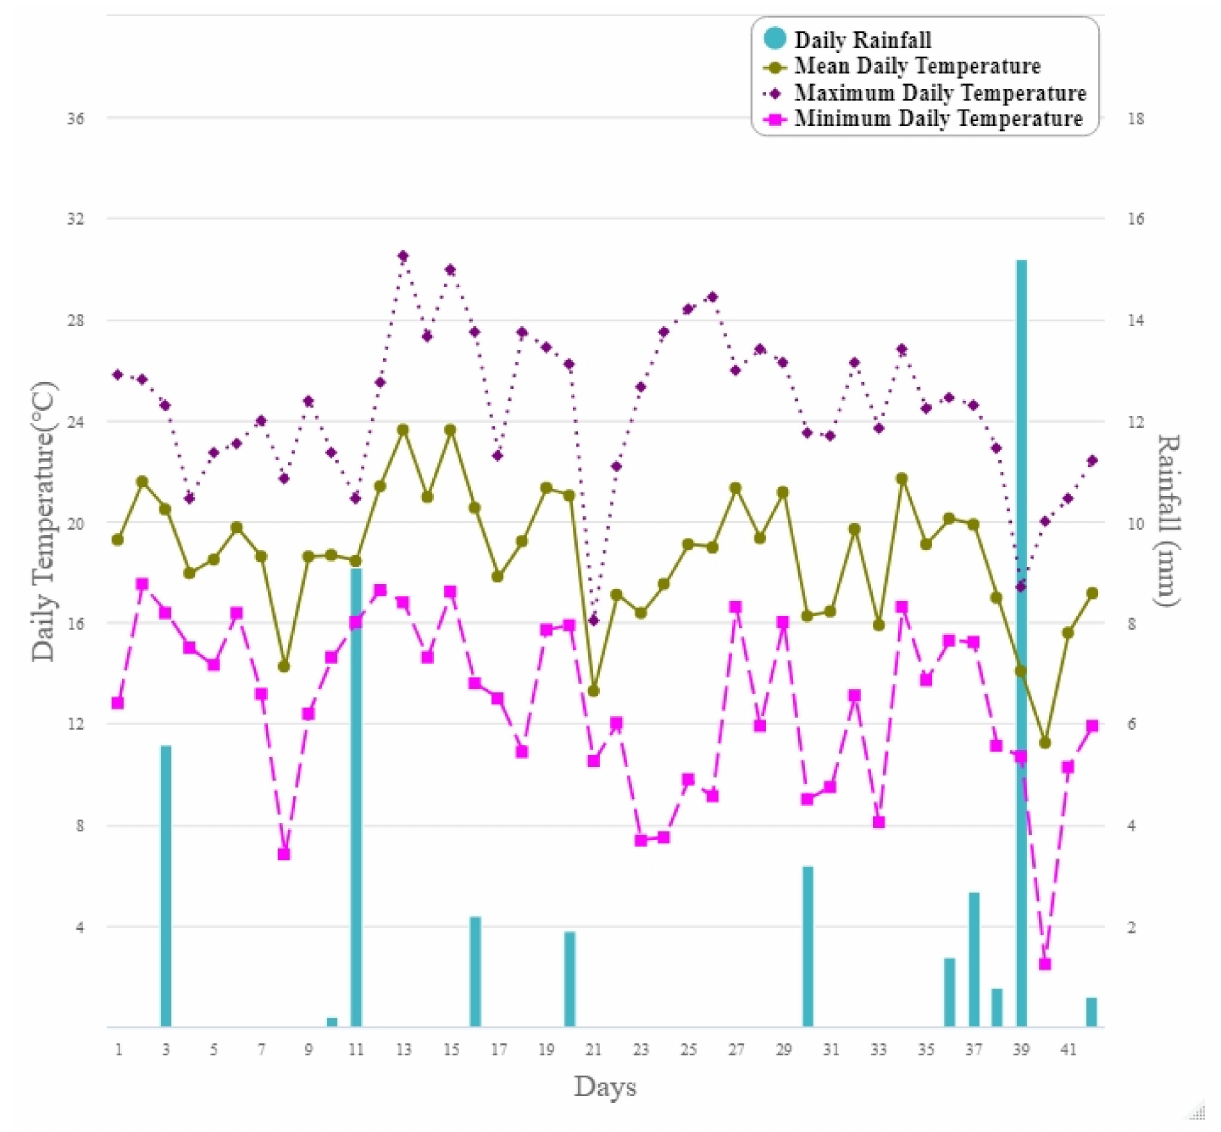
Figure 7. The mean, maximum and minimum temperature ( ◦ C) and rainfall (mm) over 42 days (18 January–1 March 2019) from Palmerston North Airport (40 ◦ 19 (cid:48) 15.6 (cid:48)(cid:48) S latitude, 175 ◦ 37 (cid:48) 05.7 (cid:48)(cid:48) E longitude) managed by the National Meteorological Service (https://cliflo.niwa.co.nz/, accessed on 1 October 2019) approximately 8 km from the study